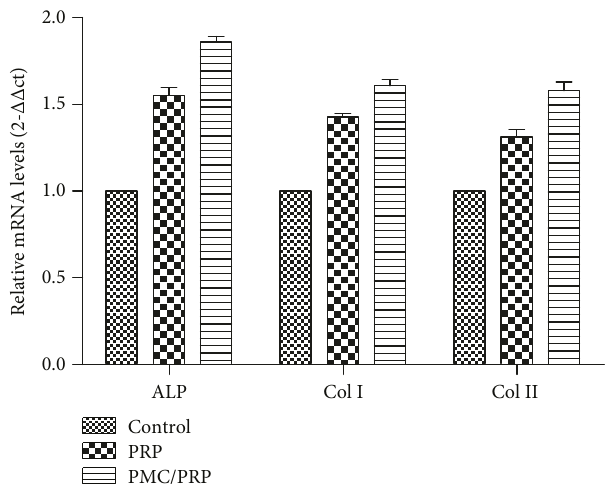
Figure 4: Expression of ALP, Col I, and Col II in BMSCs induced by PCM/PRP composites in vitro.